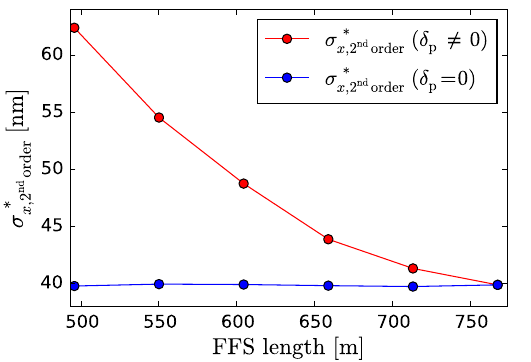
FIG. 17. Horizontal beam size σ (cid:1) x including only second-order aberrations, simulated before L of the FFS length.